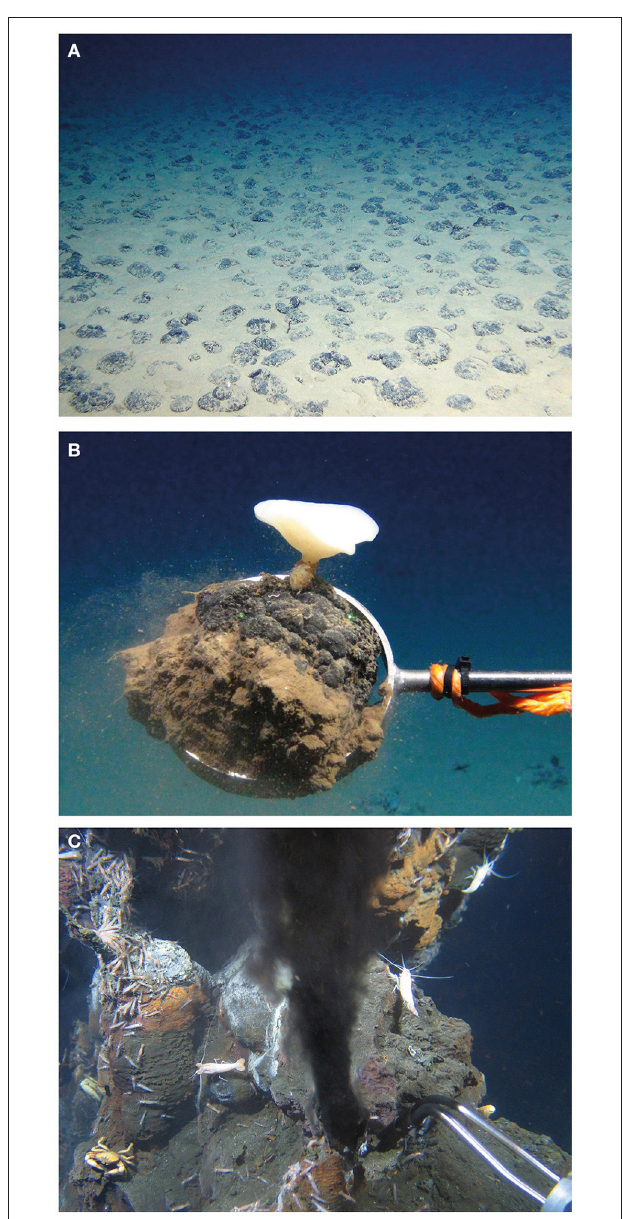
FIGURE 2 | Types of mineral deposit. (A) Manganese nodules in the Clarion Clipperton Zone, Pacific Ocean, (B) ROV KIEL 6000 holding a manganese nodule with associated fauna, (C) Black smoker (vent) on the mid-Atlantic ridge with deep sea shrimps and temperature measuring device. Photo taken by ROV KIEL 6000 during cruise M78/2. Copyright ROV Team; GEOMAR Helmholtz Centre for Ocean Research,